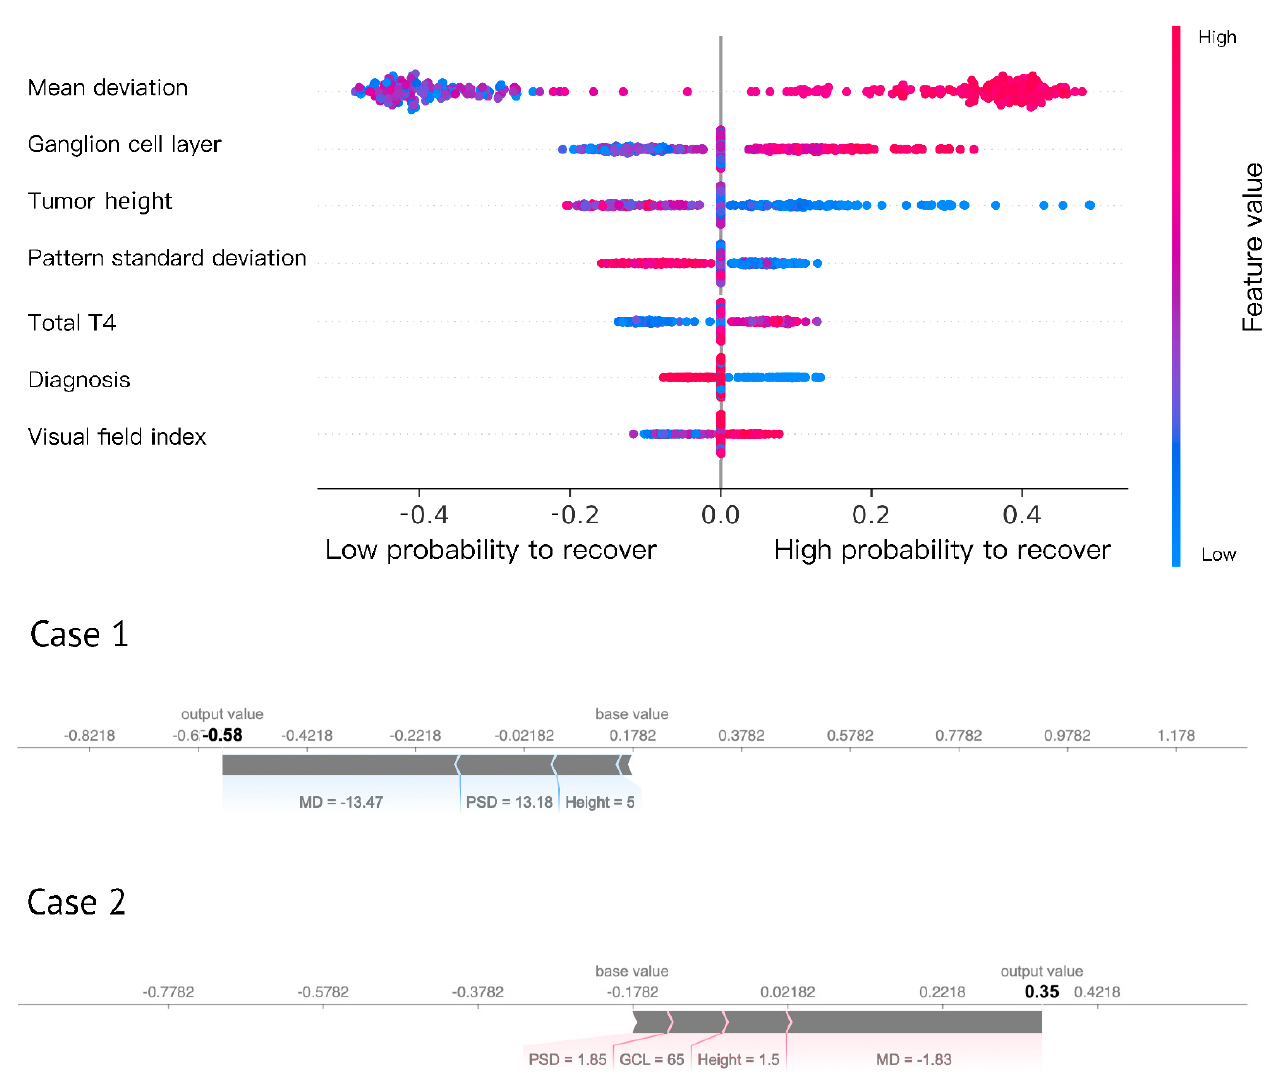
Figure 5. SHAP score-based model explanation. Every dot in the figure represents a patient. The X- axis represents the contribution to prediction (SHAP score). The variables were ordered by importance (width). Red (high) and blue (low) represent the values of the variables, e.g., for Ganglion cell layer, red means high and blue means low. Two representative cases: a severe visual field and pituitary macroadenoma contribute to the low probability of recovery (negative output) in Case 1, while a mild visual field defect, normal ganglion cell layer, and small tumor contribute to the high probability of recovery (positive output) in Case 2.